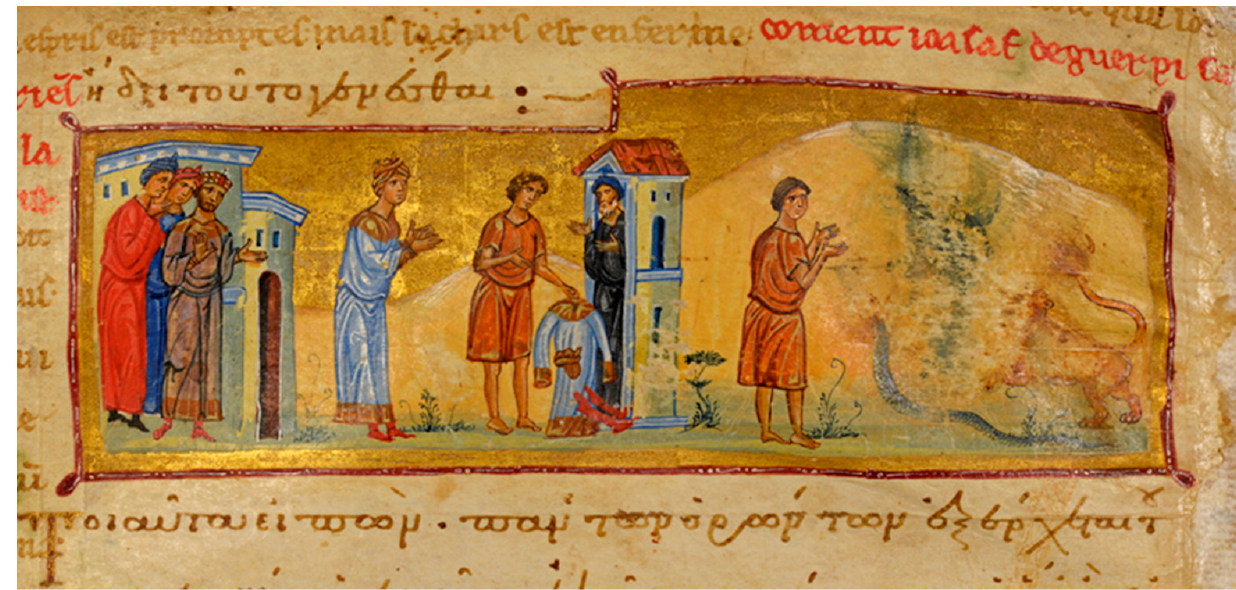
Figure 5. Mount Athos. Holy Iviron Monastery. Athon. Iviron 463, fol. 14r (detail). Ioasaph desires